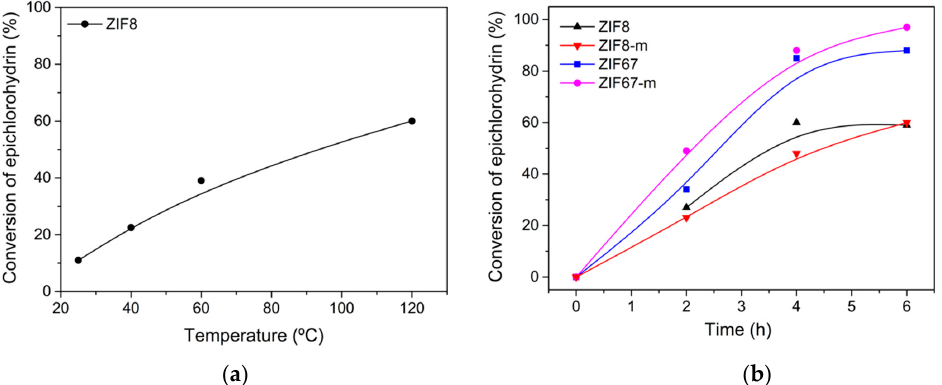
Figure 8. ( a ) Effect of the temperature in the catalytic cycloaddition of CO 2 with epichlorohydrin using ZIF-8. Conditions: 99.4 mol.% of epichlorohydrin, 0.6 mol.% of ZIF catalysts, 7 bar CO 2 , 6 h. ( b ) Catalytic reaction of cycloaddition of CO 2 with four different catalysts (ZIF-8, ZIF-8-m, ZIF-67 and ZIF-67-m). Conditions: 99.4 mol.% of epichlorohydrin, 0.6 mol.% of ZIF catalysts, 7 bar CO 2 , 120 °C. The conversion of epichlorohydrin was based on 1 H-NMR results (3-chloropropene carbonate was the only product).